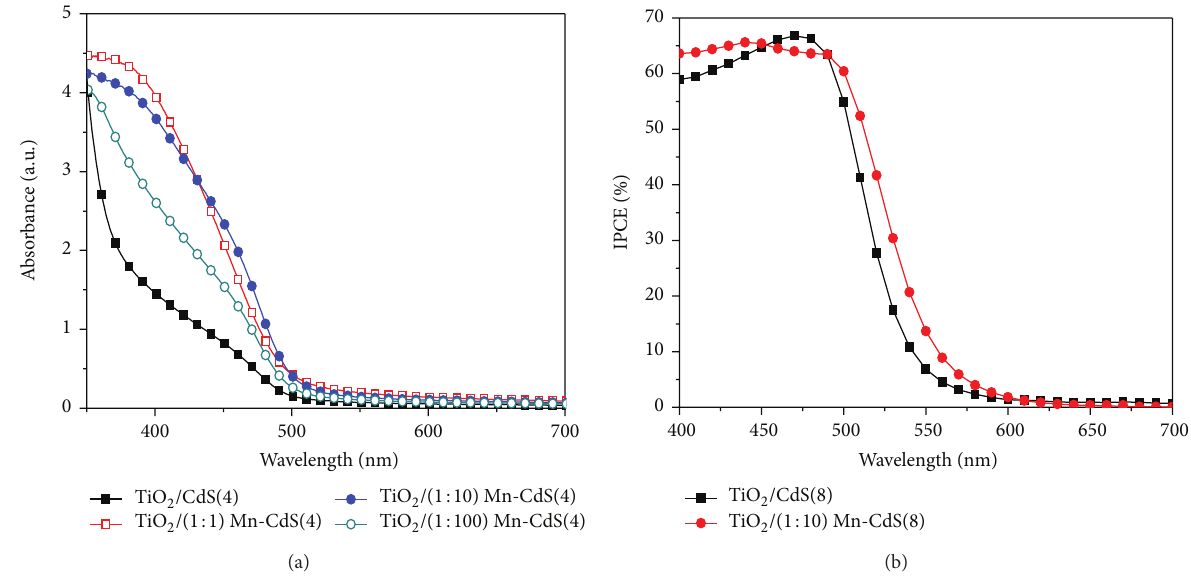
Figure 2: (a) UV-Vis absorption spectra and (b) IPCE spectra of undoped CdS QDs and different doped ratio of Mn-doped-CdS QDs.